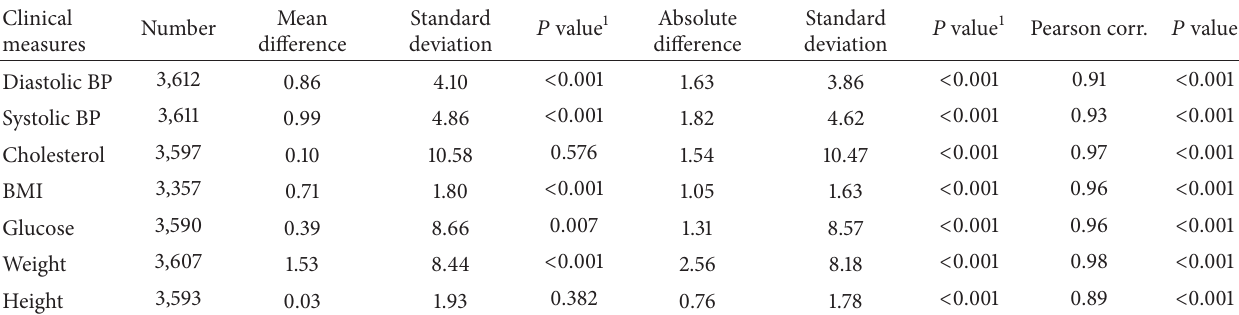
Table 2: Mean differences between self-reported values and recorded values on clinical